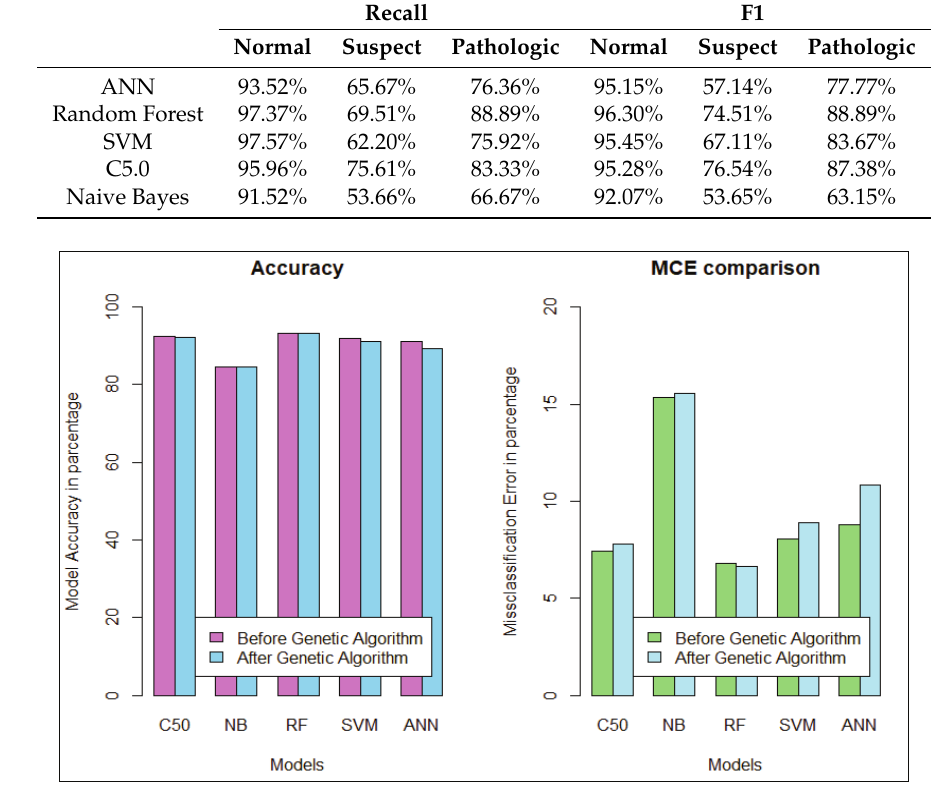
Figure 6. Accuracy and MCE for CTG.